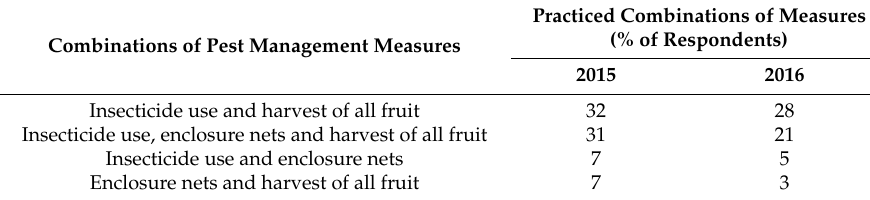
Table 4. Adoption of combinations of pest management measures against Drosophila suzukii in a sample of Swiss sweet cherry growers in two consecutive years ( N = 111 and N = 298 in 2015 and 2016, respectively). Combinations of measures are listed in descending order of frequency of